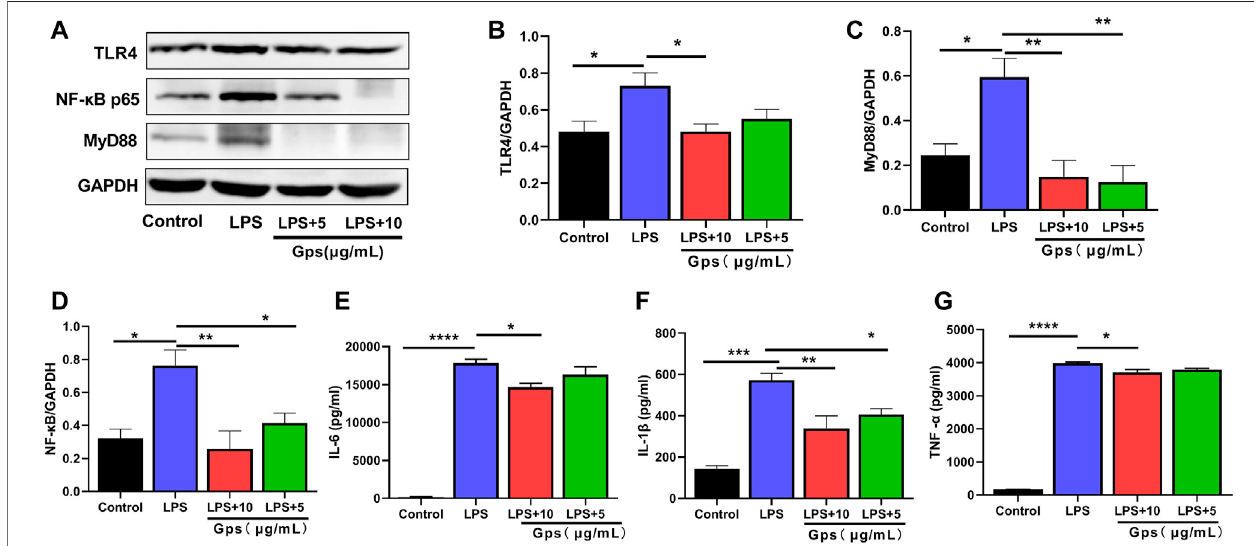
FIGURE3| GpsinhibitedtheLPS-induced NF- κ BsignalingpathwaysinBV-2cells. (A) RepresentativeimmunoreactivebandsshowingtheTLR4,MyD88andNF- κ Bp65proteinsinthecontrol(untreated),LPS(50 μ g/ml),LPS(50 μ g/ml)andGps(10 μ g/mlor5 μ g/ml,respectively)BV-2cells. (B – D) StatisticalresultsshowthatLPS increasedtheexpressionofTLR4,MyD88,andNF- κ Bp65proteins invitro ,whileGpsinhibitedtheeffectsofLPS. (E – G) Thedownstreamin fl ammatoryfactorsIL-1 β ,IL- 6,andTNF- α levelsofTLR4/MyD88/NF- κ Bsignaling invitro weredetectedbyELISA.Theresultswereexpressedasmean±SEM. n =3foreachgroup.*, p < 0.05;